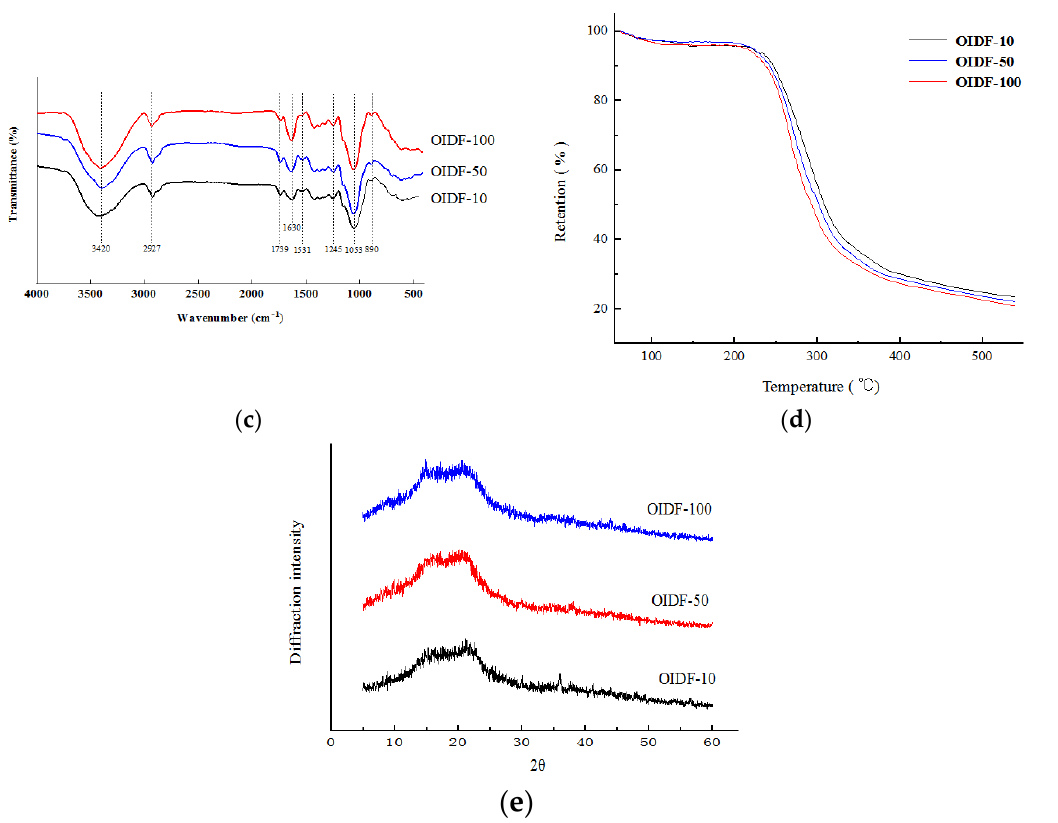
Figure 1. Structural characterization of OIDF with three particle sizes: ( a ) Particle size characterization; ( b ) SEM characterization; ( c ) FI-IR characterization; ( d ) TG characterization; ( e ) XRD characterization). Figure 1b ( A : OIDF-10, 1000×; B : OIDF-10, 8000×; C : OIDF-50, 1000×; D : OIDF-50, 8000×; E : OIDF-100, 1000×; F : OIDF-100, 8000×).